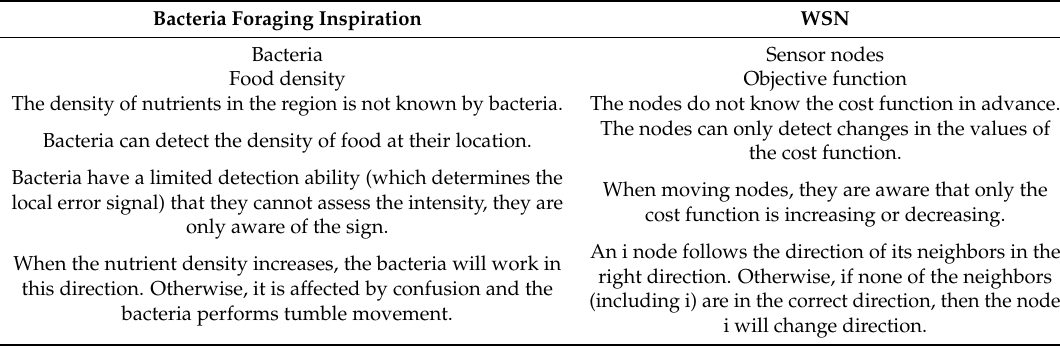
Table 1. Similarity between bacteria life and wireless sensor network